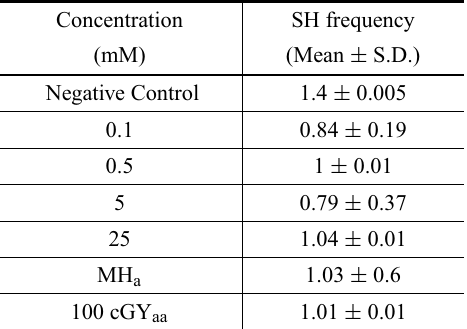
Frequency of mutation (mutations/100) in stamen hairs of Tradescantia pallida var. purpurea treated with different NDEA concentrations. Concentration (Mean ±